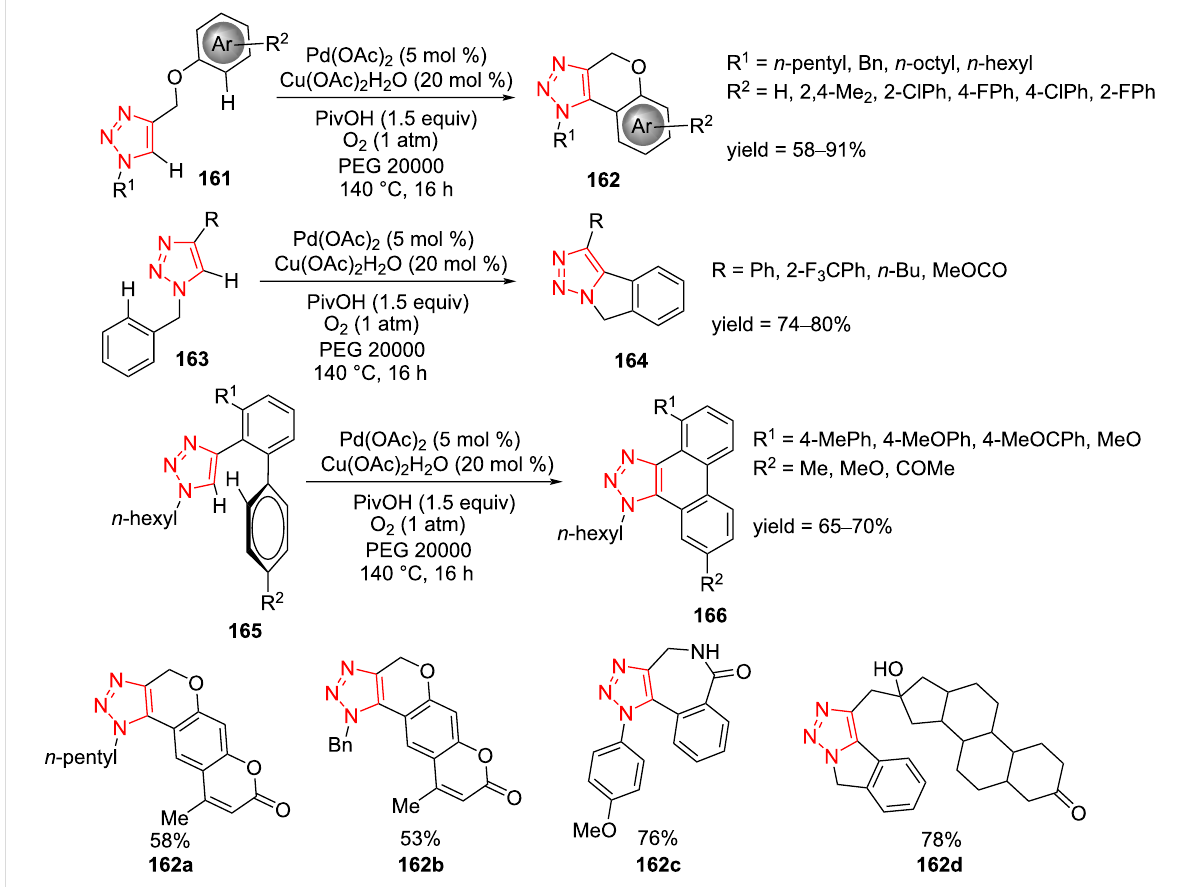
Scheme 44: Synthesis of fully functionalized 1,2,3-triazolo-fused chromenes 162 , 164 , and 166 via the intramolecular oxidative C–H arylation of 1,2,3-triazoles 161 , 163 , and 165 .